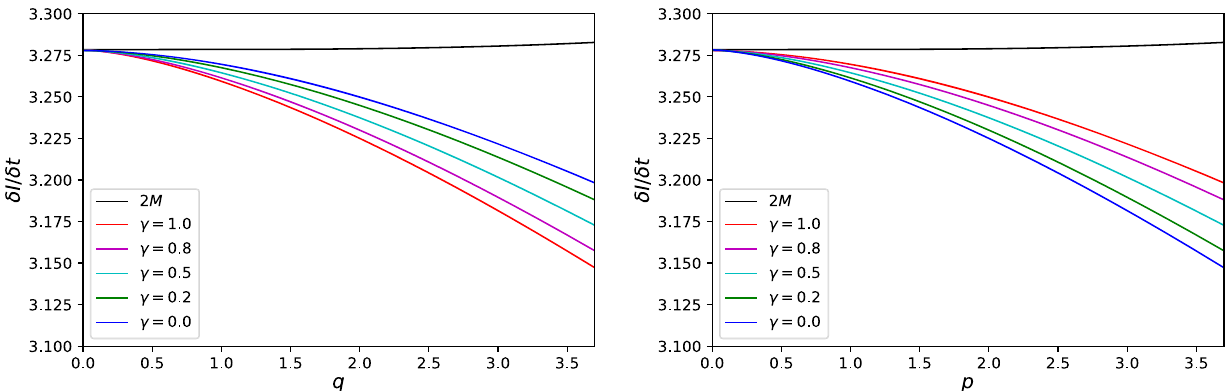
Fig. 6 δ I δ versus q with fixed p (left plot) and δ I δ versus p with fixed q (right plot) for four-dimensional dyonic black hole with single horizon. t t The parameters are fixed as β = 0 . 15 , r + = 5 ,(cid:3) = − 1 , p = 0 . 1 for the left plot, and β = 0 . 15 , r + = 5 ,(cid:3) = − 1 , q = 0 . 1 for the right